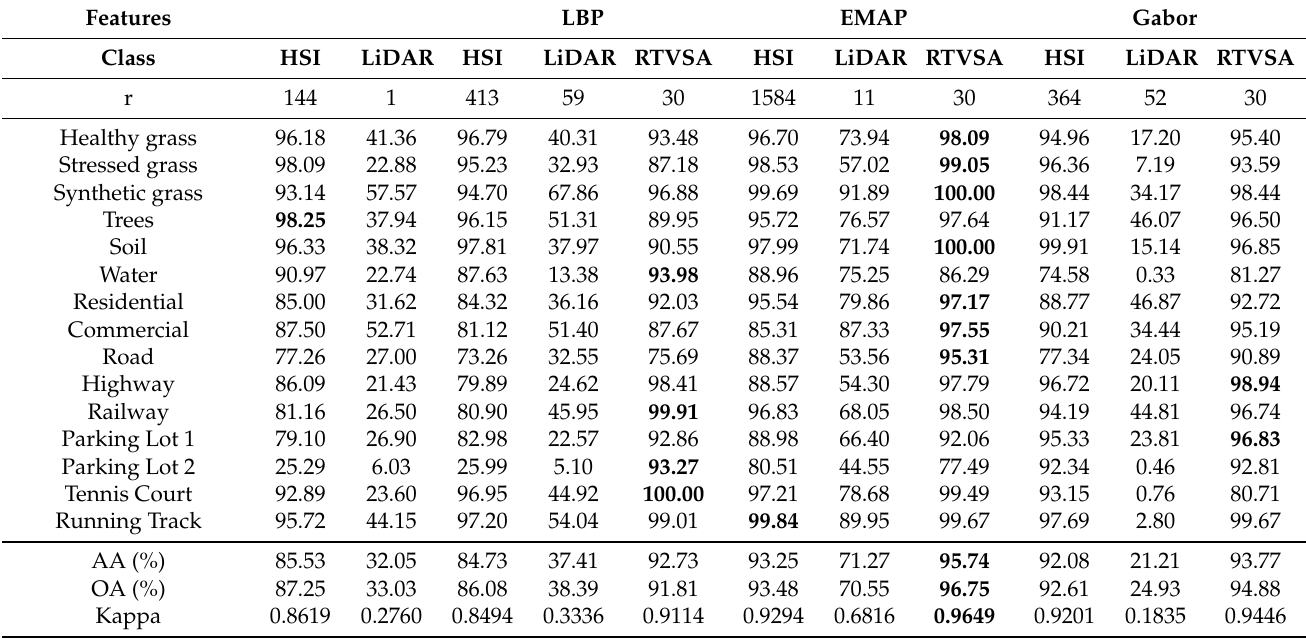
Table 2. The RF classification performance of the proposed method based on the LBP, EMAP, and Gabor feature extraction on the 2012 Houston dataset (%). The best values are shown in bold.